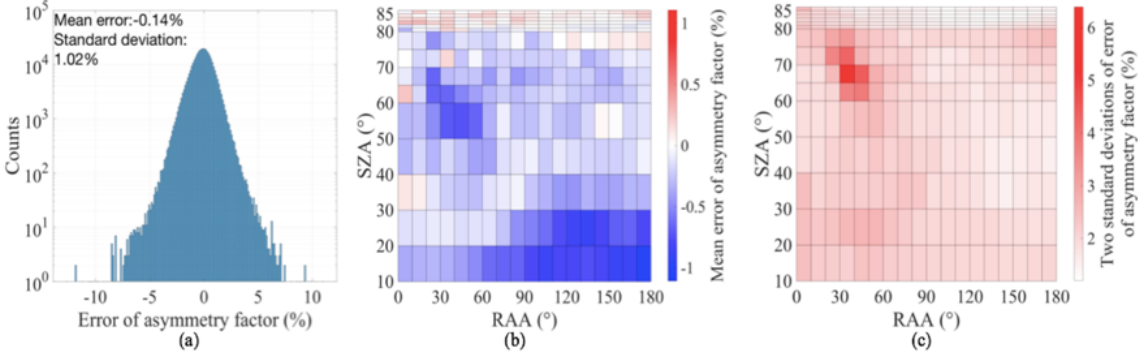
Figure 8. Asymmetry factor retrieval errors: (a) error histogram; (b) mean error as a function of SZA and RAA; (c) 2 standard deviations as a function of SZA and RAA.